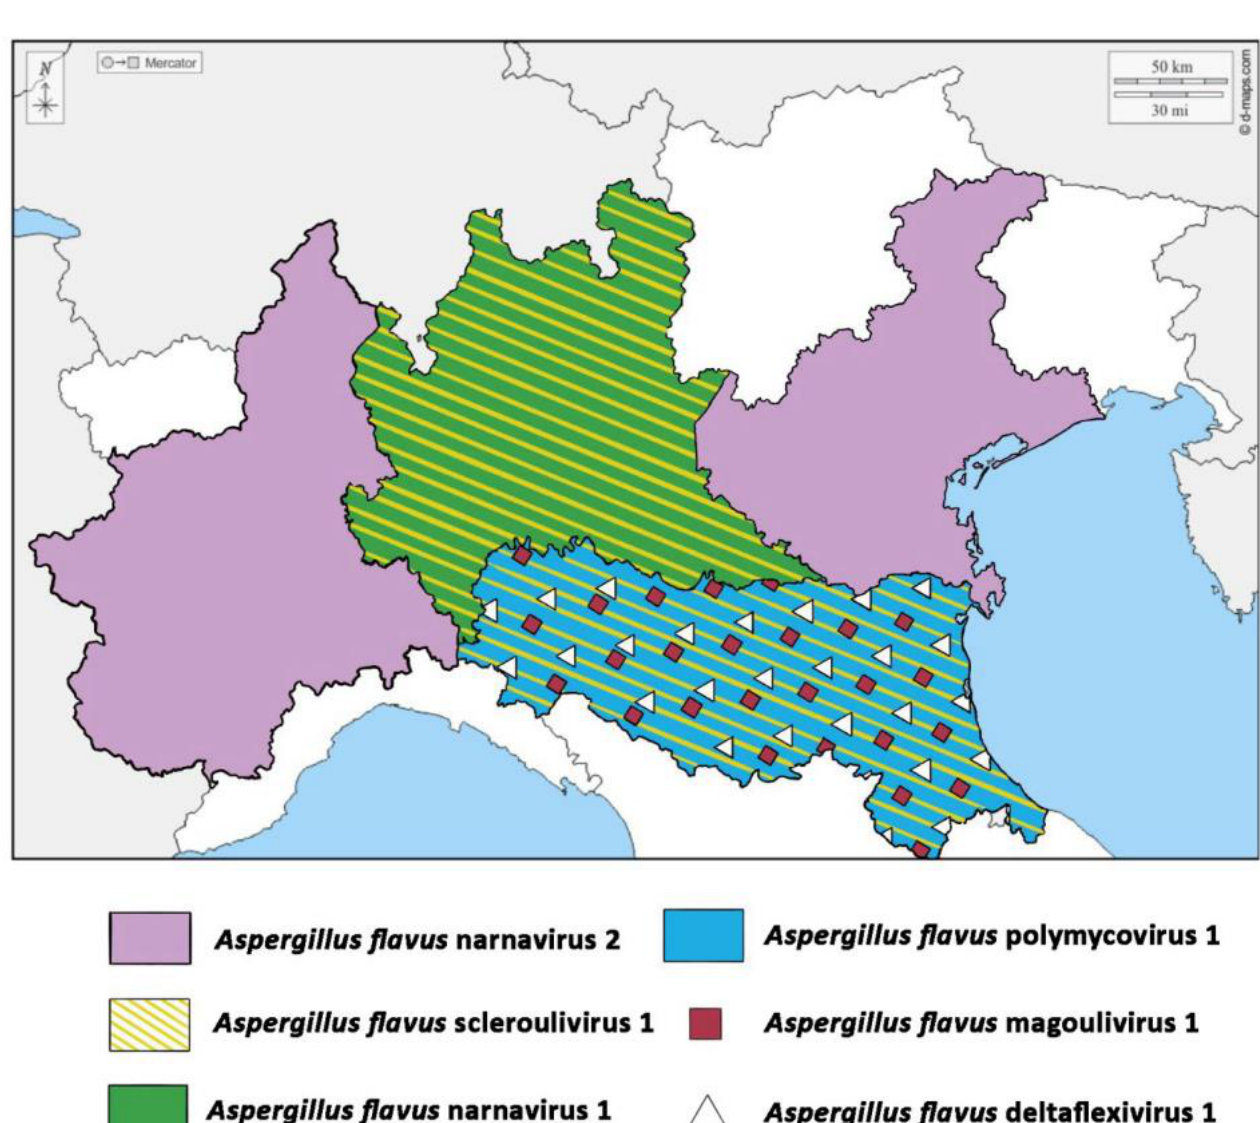
Figure 7. Map of Northern Italy showing the basin of origin of A. flavus strains isolated and used in the present work. Original map courtesy of: https://d-maps.com/carte.php?num_car=5892&lang=it, accessed on 22 May 2021.